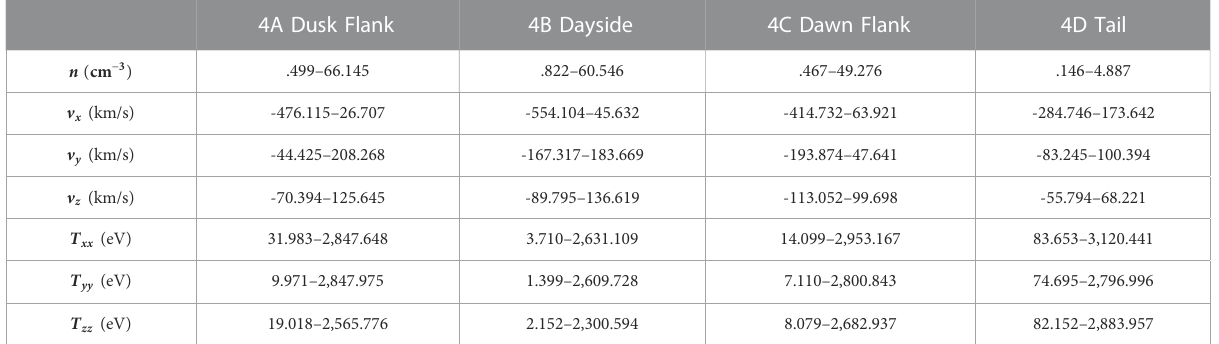
TABLE 2 95% range (2.5% and 97.5% percentiles) of test set values to better interpret Figure